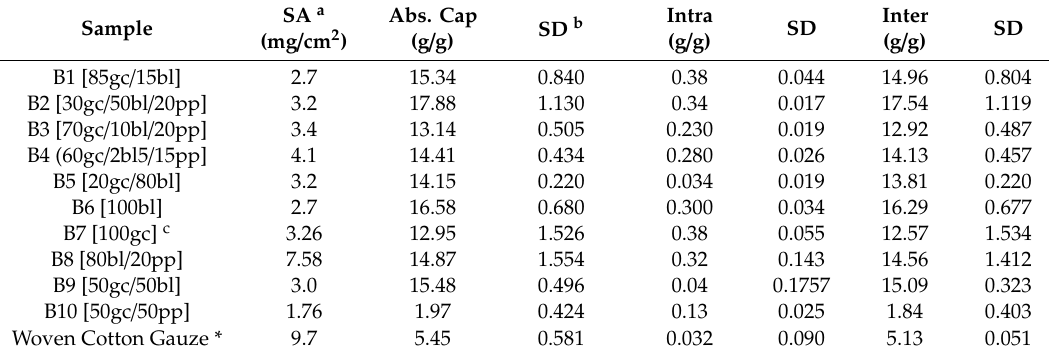
Table 3. Absorption Capacities of physiological saline for both intra-fiber and inter-fiber of the nonwoven